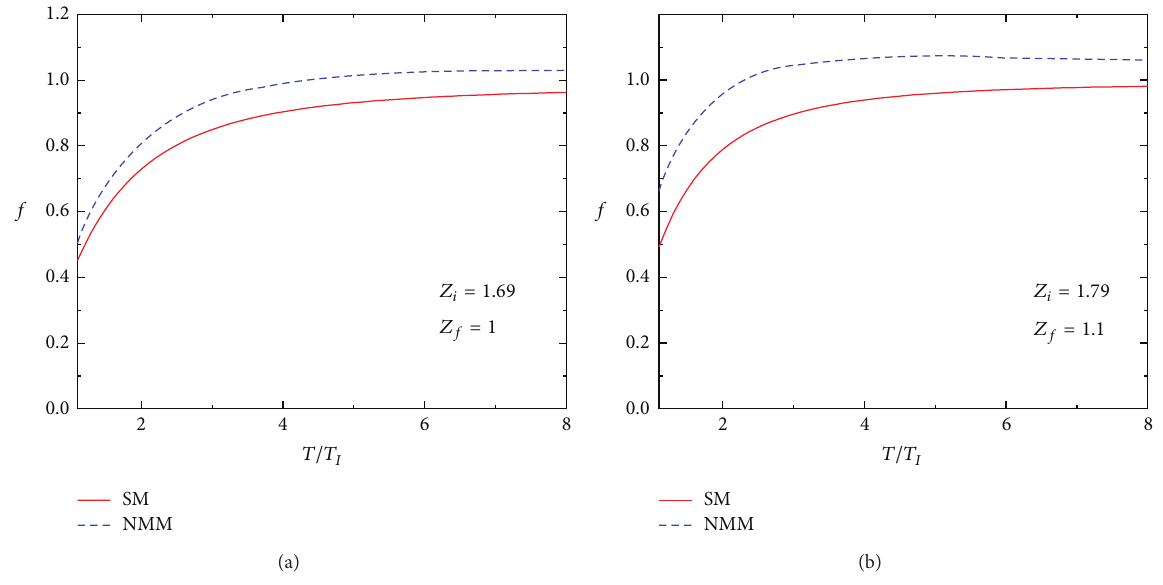
Figure 4: Atomic factors (65) as functions of the energy transfer